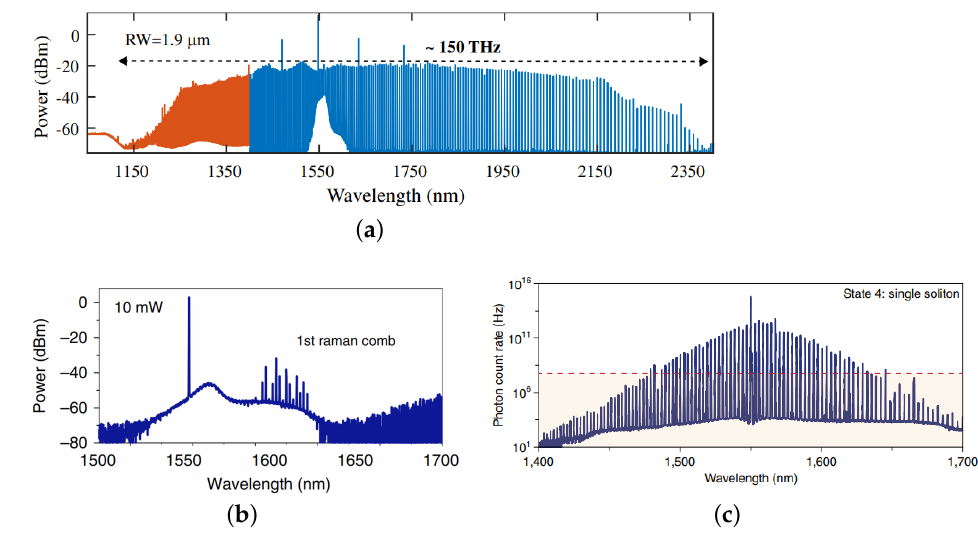
Figure 4. Experimental spectra of ( a ) octave-spanning Kerr frequency comb reprinted with permis- sion from [57], ( b ) Raman comb, reprinted with permission from [56], and ( c ) quantum soliton comb, reprinted with permission from [71] in SiC